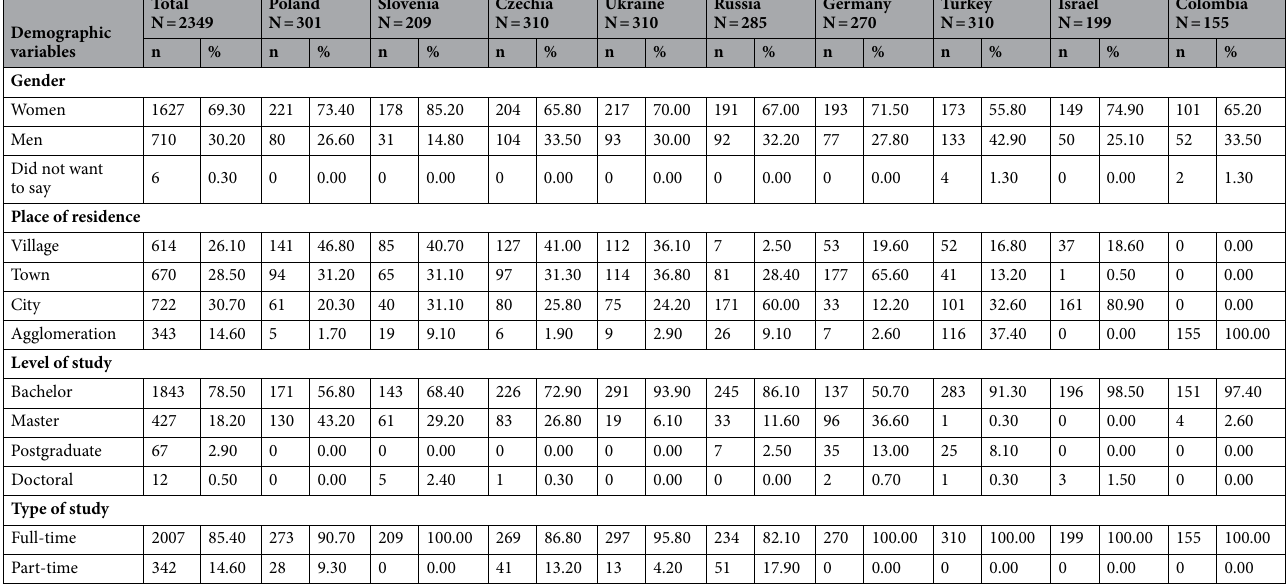
Table 1. Demographic characteristics of the study sample in the nine countries.